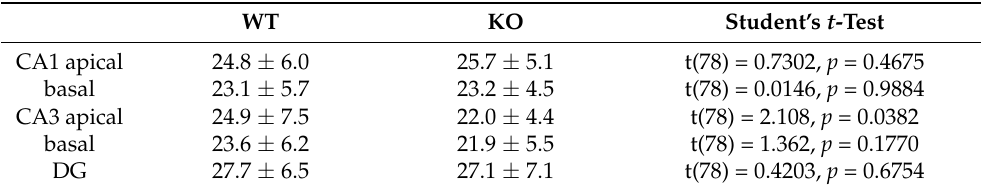
Table 3. Results of Student’s t -tests for the dendritic spine density (per dendritic segments of 10 µ m) of the hippocampal neurons in each subregion between WT and KO mice ( n = 40 dendritic segments/group).